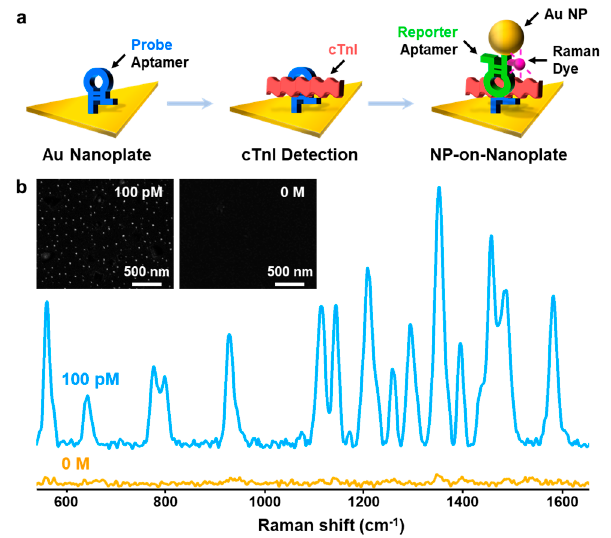
Figure 1. ( a ) Schematic representation of the cardiac troponin I protein (cTnI) detection procedure using an aptamer-immobilized Au nanoplate. ( b ) Surface-enhanced Raman scattering (SERS) spectra of Cy5 measured from Au nanoparticles (NPs)-on-nanoplate structure after detection of cTnI (100 pM, blue spectrum) and the control sample (orange spectrum). The inset shows SEM images of Au NPs-on-nanoplate structures after detection of cTnI (left panel) and the control sample (right panel).